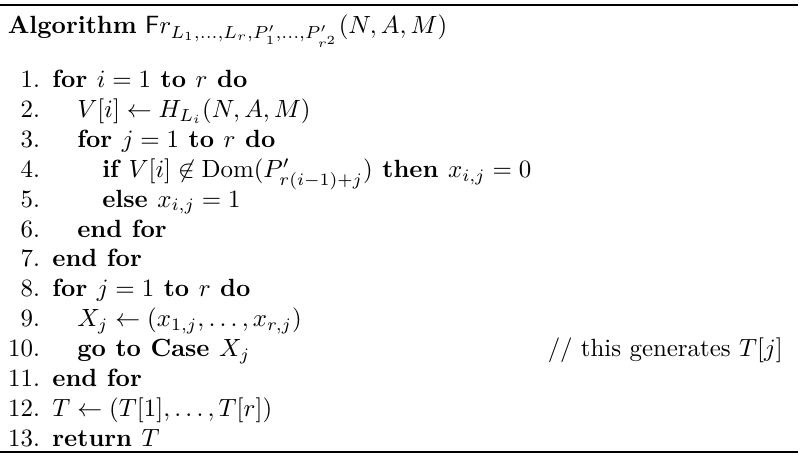
L 1 ,...,L r ,P 0 1 ,...,P 0